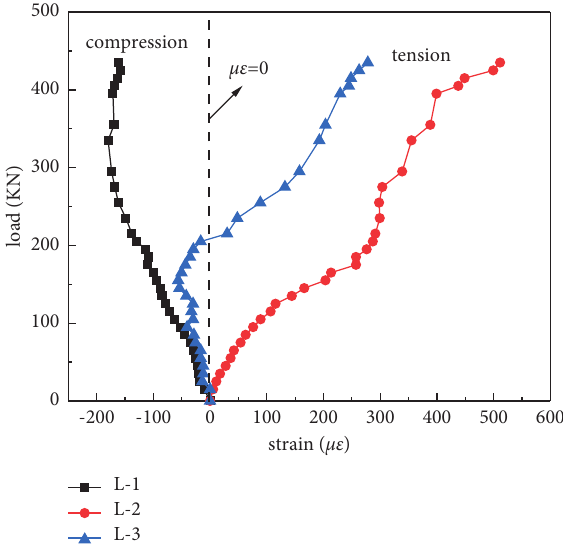
Figure 10: Load-strain relationship curves of